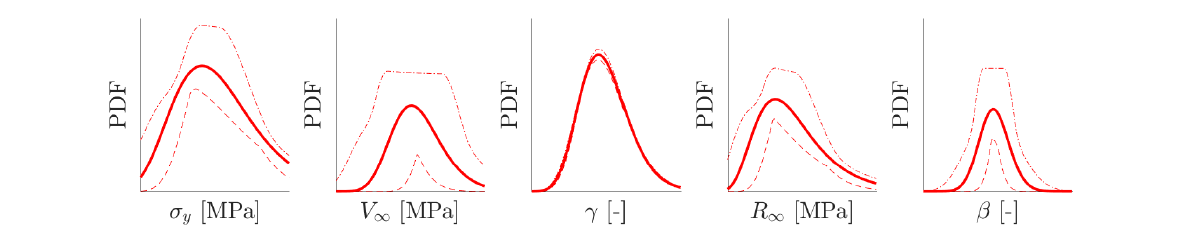
Figure 6. Validation: Identified parameters’ marginal PDF corresponding to hyperparameters’ means accompanied by bounds corresponding to 90 % of hyperparameters’ values.